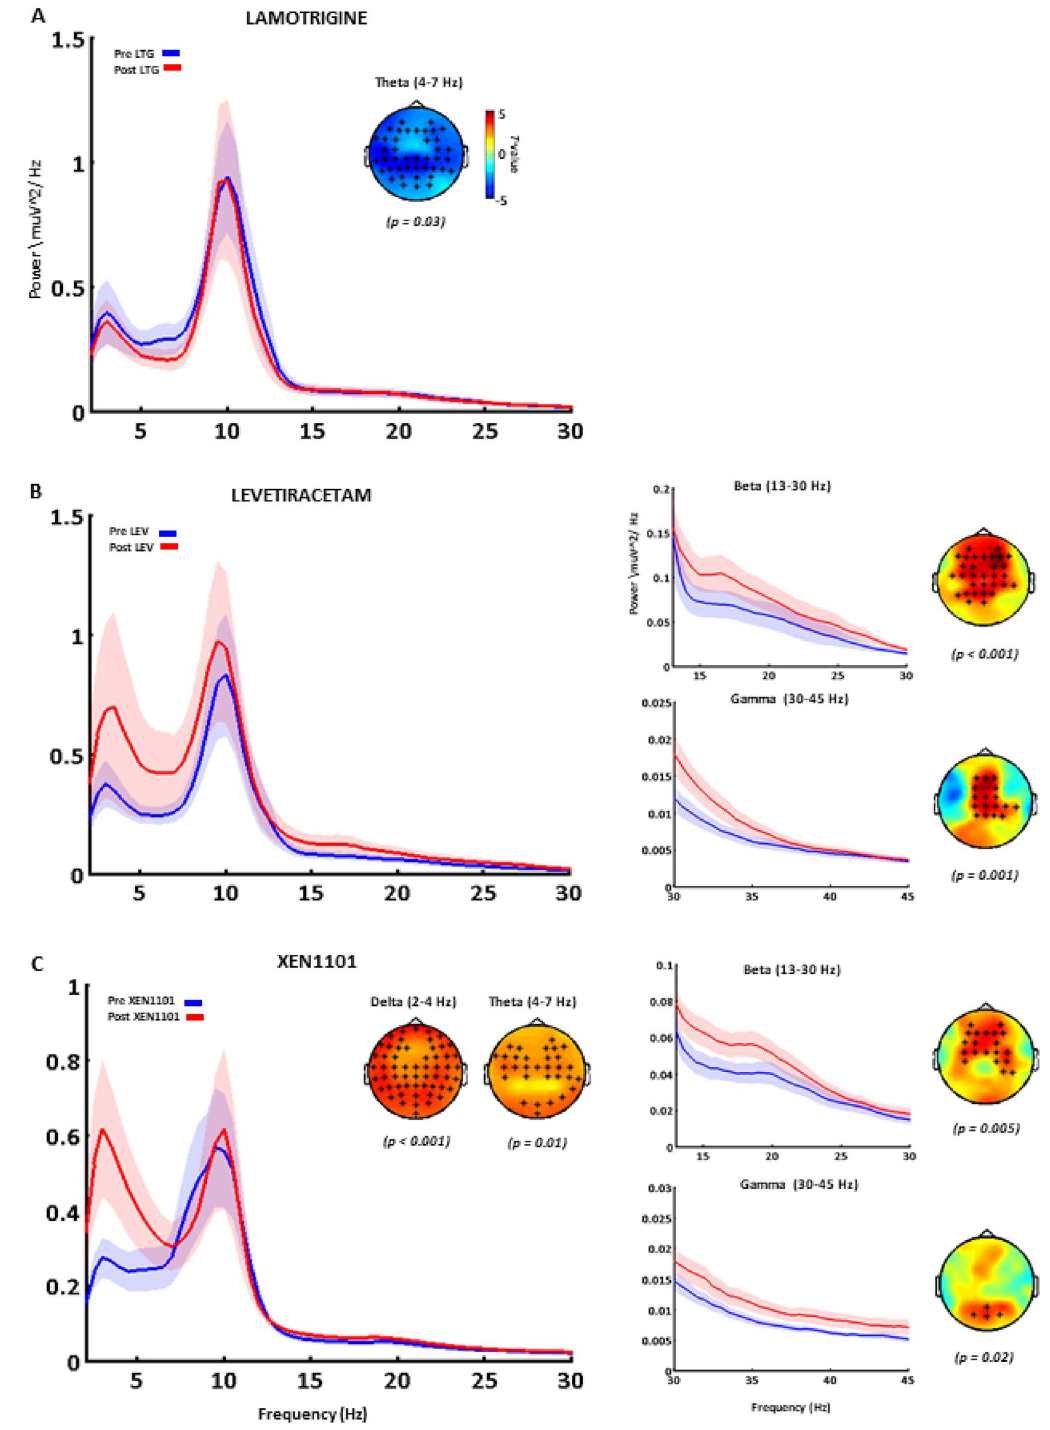
Figure 5. The effects of antiepileptic drugs on resting-state EEG oscillations. Grand-averaged power spectrums calculated on the average of all channels are reported before (pre, blue) and after (post, red) the intake of Lamotrigine ( a ), Levetiracetam ( b ) and XEN1101 ( c ). For each drug condition, significant differences are indicated with the respective topographical distribution of t-values where significant channels are indicated with asterisks. Lamotrigine ( a ) decreases theta power (p = 0.03); Levetiracetam ( b ) increases theta (p = 0.03), beta (p < 0.001) and gamma (p = 0.001) power; XEN1101 increases delta (p < 0.001), theta (p = 0.01), beta (p = 0.005) and gamma (p = 0.02) power. The significant modulation of beta and gamma power are shown for each drug in a zoomed power spectrum (panels on the right; averaged over significant channels for Levetiracetam and XEN1101,